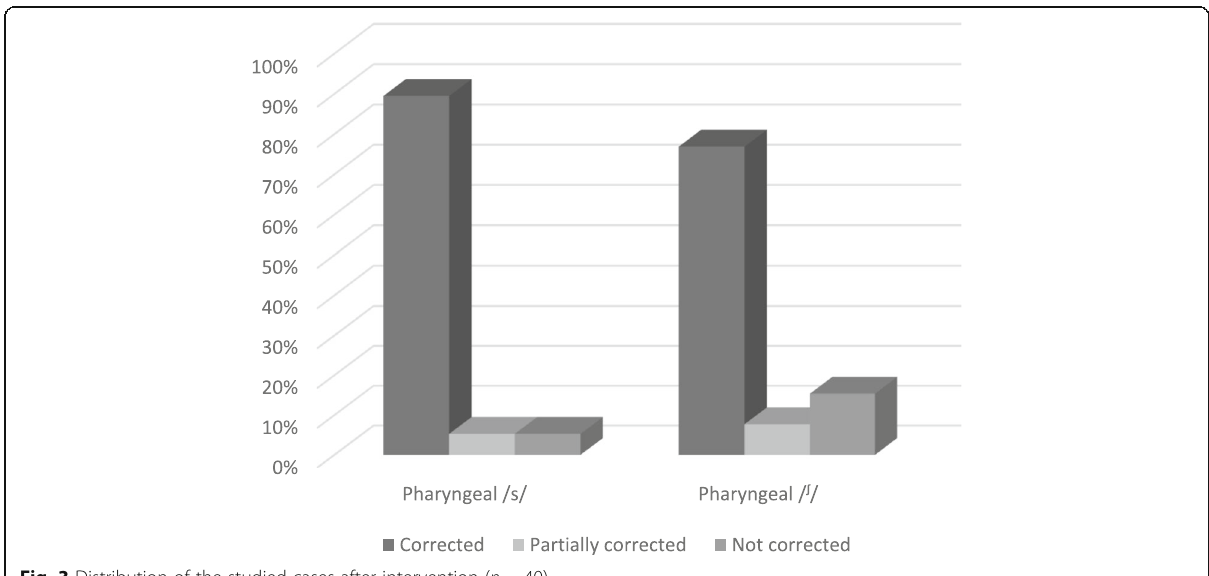
Fig. 3 Distribution of the studied cases after intervention ( n = 40)